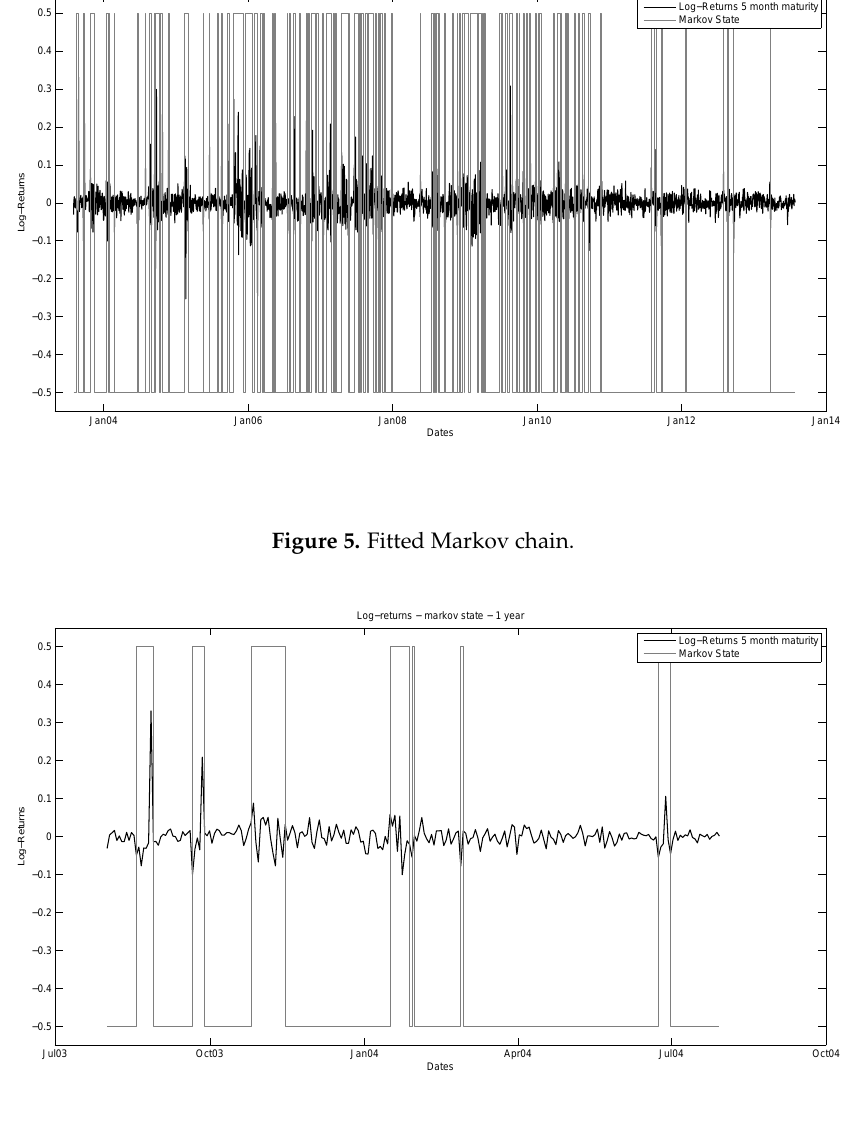
Figure 6. Fitted Markov chain: one-year